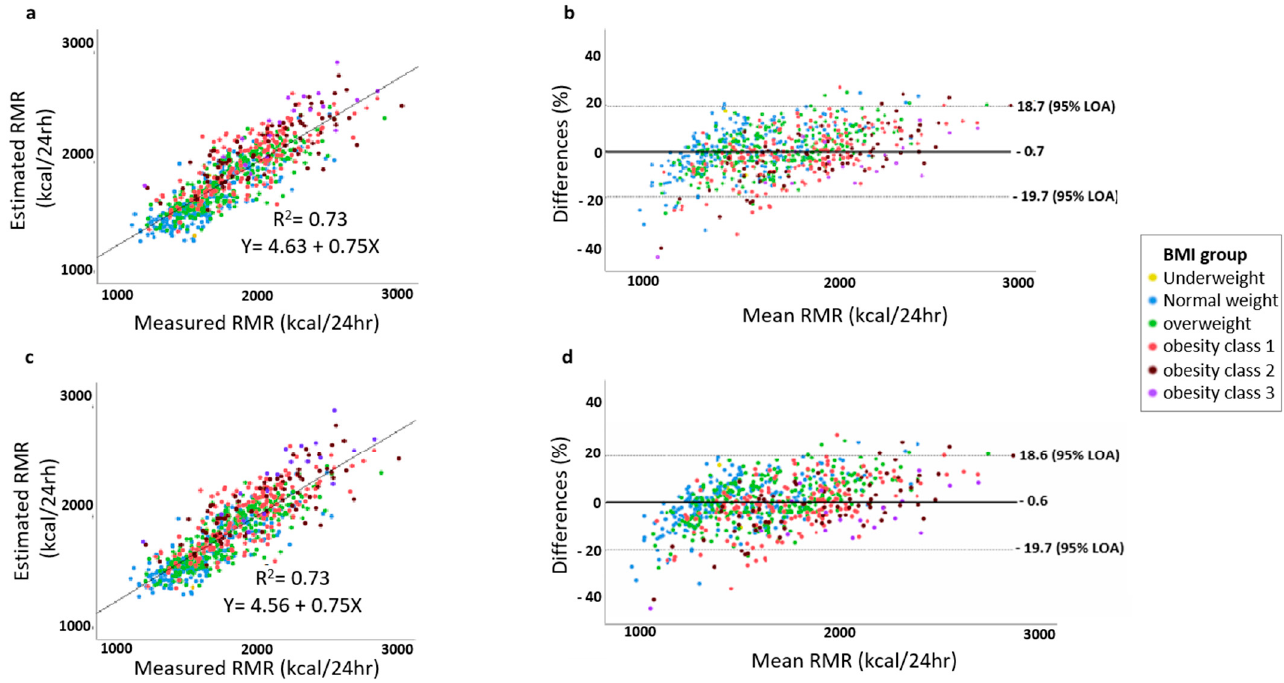
Figure 3. Bland–Altman analysis of the proposed new models applied to the validation set ( n = 750). The x-axis represents the mean of the measured and estimated RMR, and the y-axis expresses the difference in percentage between the RMR predicted using each of the equations and the RMR measured as follows: (pRMR − mRMR/mRMR)/100). Lin’s concordance correlation was used to determine the R 2 and the linear equation between each estimated equation and the measured RMR. ( a , b ) model 1, includes sex, age, FM, and FFM. ( c , d ) model 2, includes sex, age, FM, FFM, and the interaction between FM and FFM (FM*FFM).